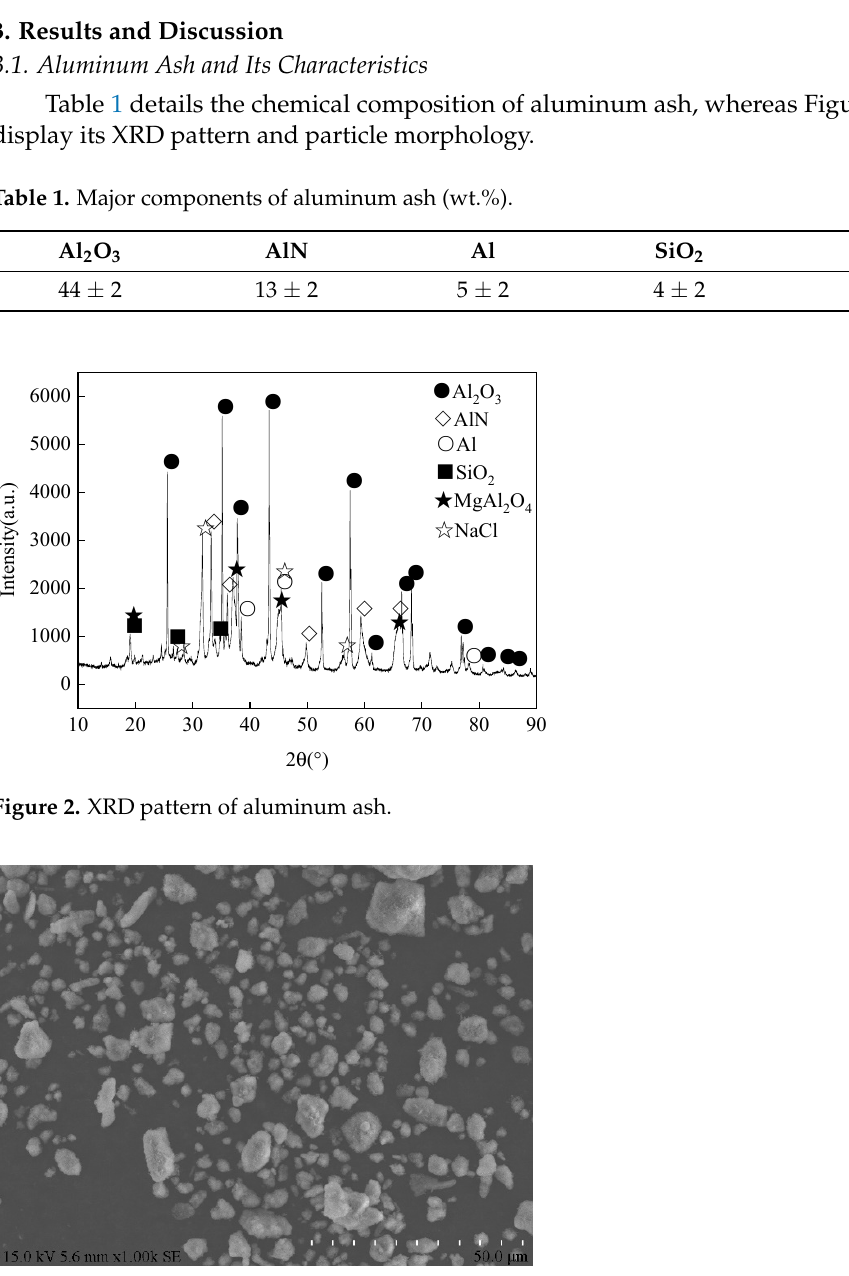
MU20 Figure 4. Effect of cement content on compressive strength.